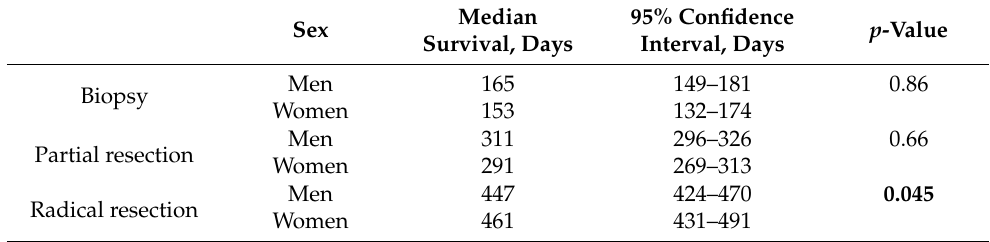
Table 2. Median survival in relation to sex and type of surgery. Better survival was noted for more extensive surgery, with a sex difference for radical resection favoring women. Significant p -value in bold. Median Sex